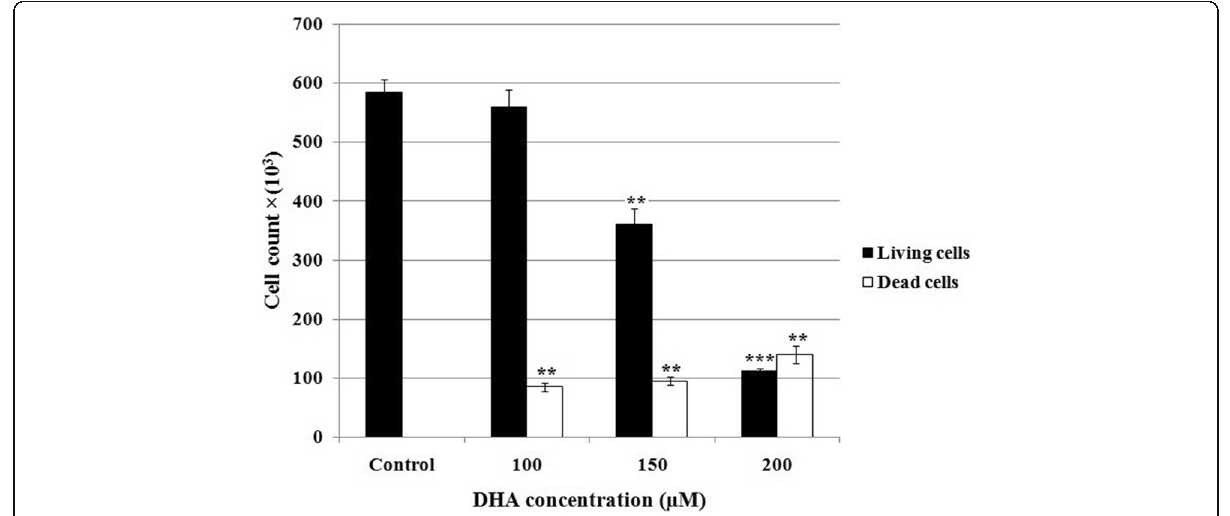
Fig. 1 Effect of DHA on the cell number. 5 × 10 5 HCT-116 cells per well were treated for 48 h with various concentrations of DHA after which number of live and dead cells were measured using trypan blue staining method. All experiments were repeated twice using triplicate assays and results were presented as Mean ± SD. ** P < 0.01 and *** P < 0.001 vs. untreated control